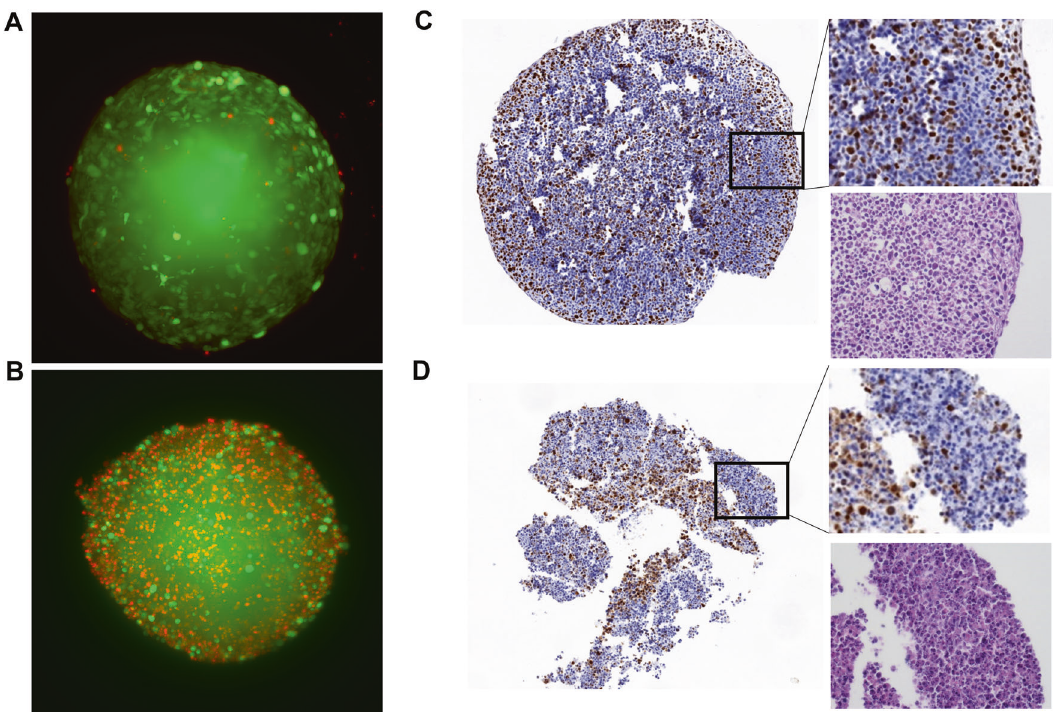
Fig. 4 Morphological assessment of spheroids. A , B RD-GFP cells cultured as 3D spheroids were left untreated ( A ) or exposed to the combination of A1331852 (0.25 μ M) and S63845 (0.3 μ M) ( B ) for 48 h before PI staining and light-sheet microscopy. C , D RD-GFP cells were cultured as large spheroids containing 50,000 cells for 7 days and either left untreated ( C ) or treated with the combination of A1331852 (0.25 μ M) and S63845 (0.3 μ M) ( D ) for 6 h before formalin fi xation and H/E staining (lower right side) or analysis of Ki-67 staining by immunohistochemistry (large image and upper right